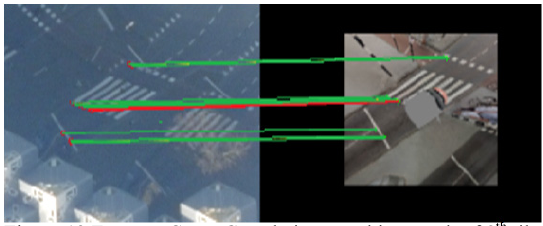
Figure 12 Förstner Cross-Correlation matching result of 8 th tile